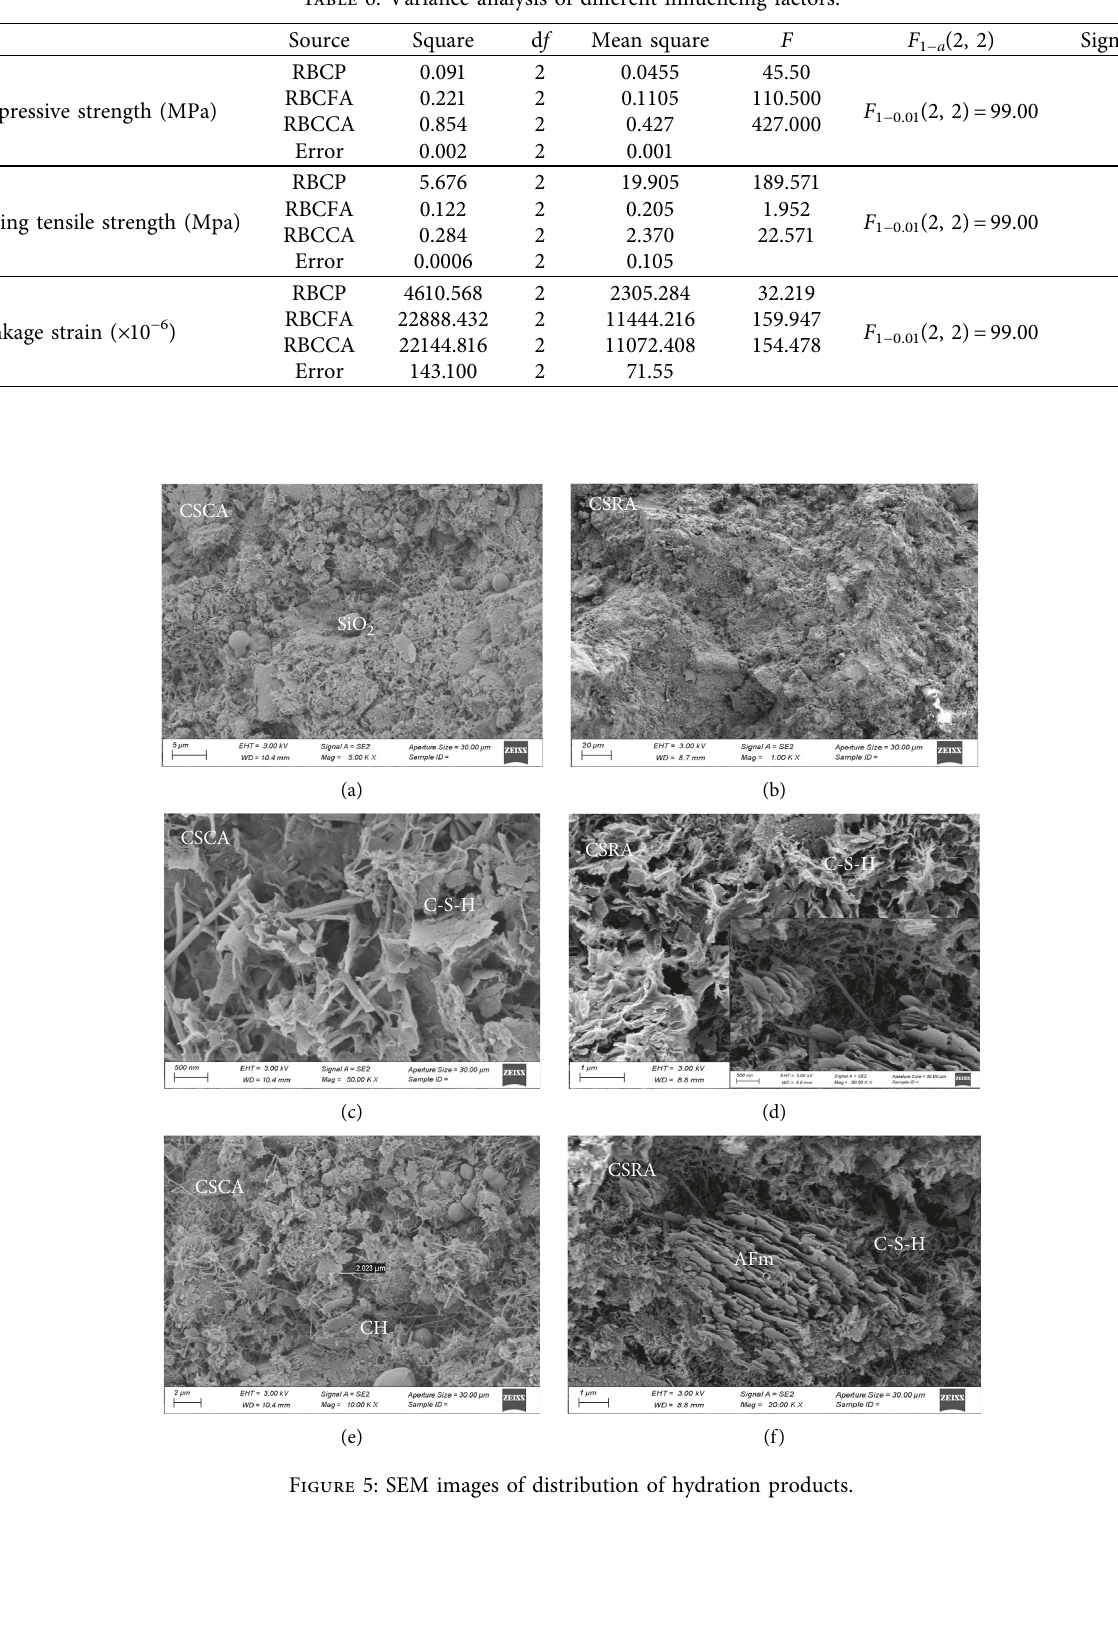
Table 6: Variance analysis of different influencing factors.